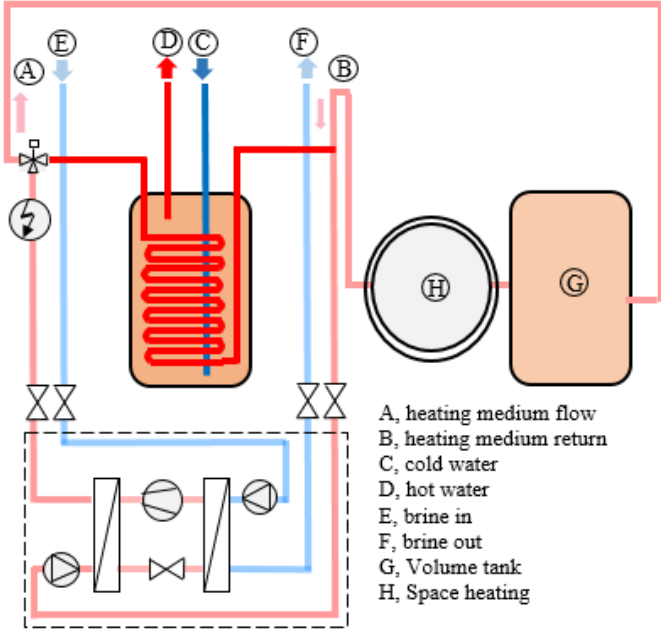
Figure 1. Typical domestic ground source heat pump (GSHP) with an alternate operation principle [26].